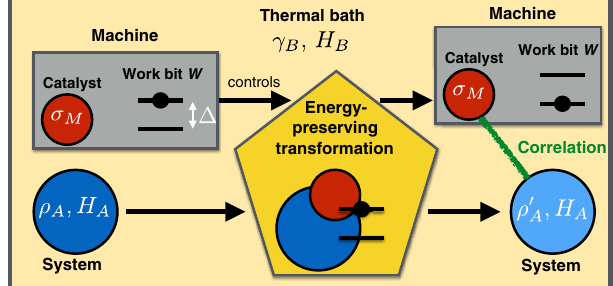
FIG. 1. Thermal operation of the form that we are considering in this paper; compare Fig. 1 in Ref. [10]. We have a system A that we would like to act on, by transforming its state ρ into another A state ρ 0 . We have access to a heat bath with an arbitrary A Hamiltonian H , which is in its thermal state γ at some fixed B B temperature T . The thermal machine contains a quantum system in state σ , and it controls a unitary transformation U M AMB (symbolized by the pentagon), acting on the system A , heat bath B , and its internal system M . Crucially, this transformation 0 . ; H H H is fully energy preserving, i.e., ½ U AMB A þ M þ B (cid:2) ¼ By tracing over the heat bath, we obtain the map σ AM ¼ ρ ⊗ σ ⊗ γ U U † Tr (cid:2) , which is, in total, a thermal B ½ AMB ð A M B Þ AMB ⊗ σ ↦ σ . We demand that the machine ’ s operation, ρ A M AM internal state σ is exactly preserved (hence, σ is often called M M a “ catalyst ” : It enables the transformation but is not consumed in σ the process), and we would like the resulting state of A , Tr , M AM to be identical (or very close) to the desired target state ρ 0 . The A difference to Ref. [10] is that we allow correlations to build up between A and M . If work is spent or extracted, we model this by an additional two-level system ( “ work bit ” ) W which, initially as well as finally, is enforced to be exactly in an energy eigenstate (ground state j g i or excited state j e i ). This restriction ensures that W remains uncorrelated with all other systems that are involved in this process; hence, the resulting work Δ can be reliably trans- ferred to or from an external